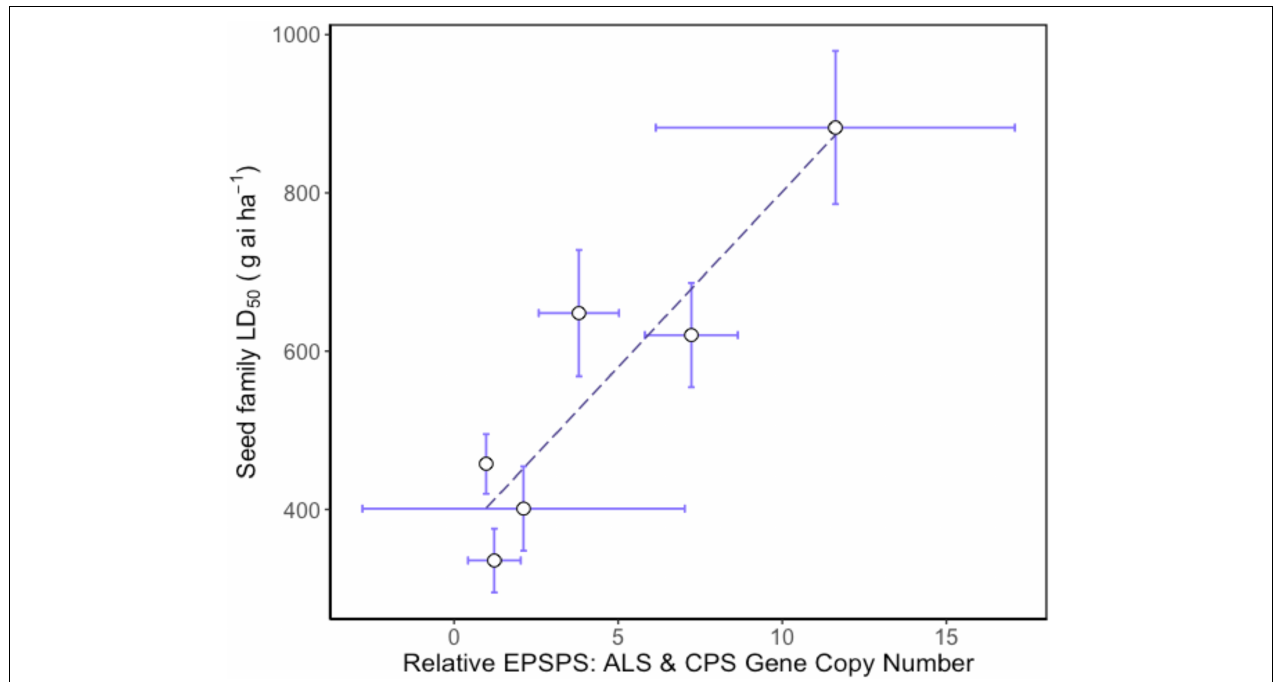
FIGURE 4 | Relationship between relative mean EPSPS gene copy number and glyphosate resistance phenotype in Amaranthus tuberculatus seed families. Mean 5-enolpyruvylshikimate-3-phosphate synthase ( EPSPS ) gene copy number is relative to carbamoyl phosphate synthetase ( CPS ) and acetolactate synthase ( ALS ) reference genes. The LD 50 for each seed family was calculated using 30 replicate plants for each of six glyphosate doses and 6–8 replicate plants from each seed family were assessed for EPSPS gene copy number. Regression analysis: f -statistic = 22.99; df = 1; 4, p = 0.0087, R 2 = 0.85. Error bars are standard errors of the